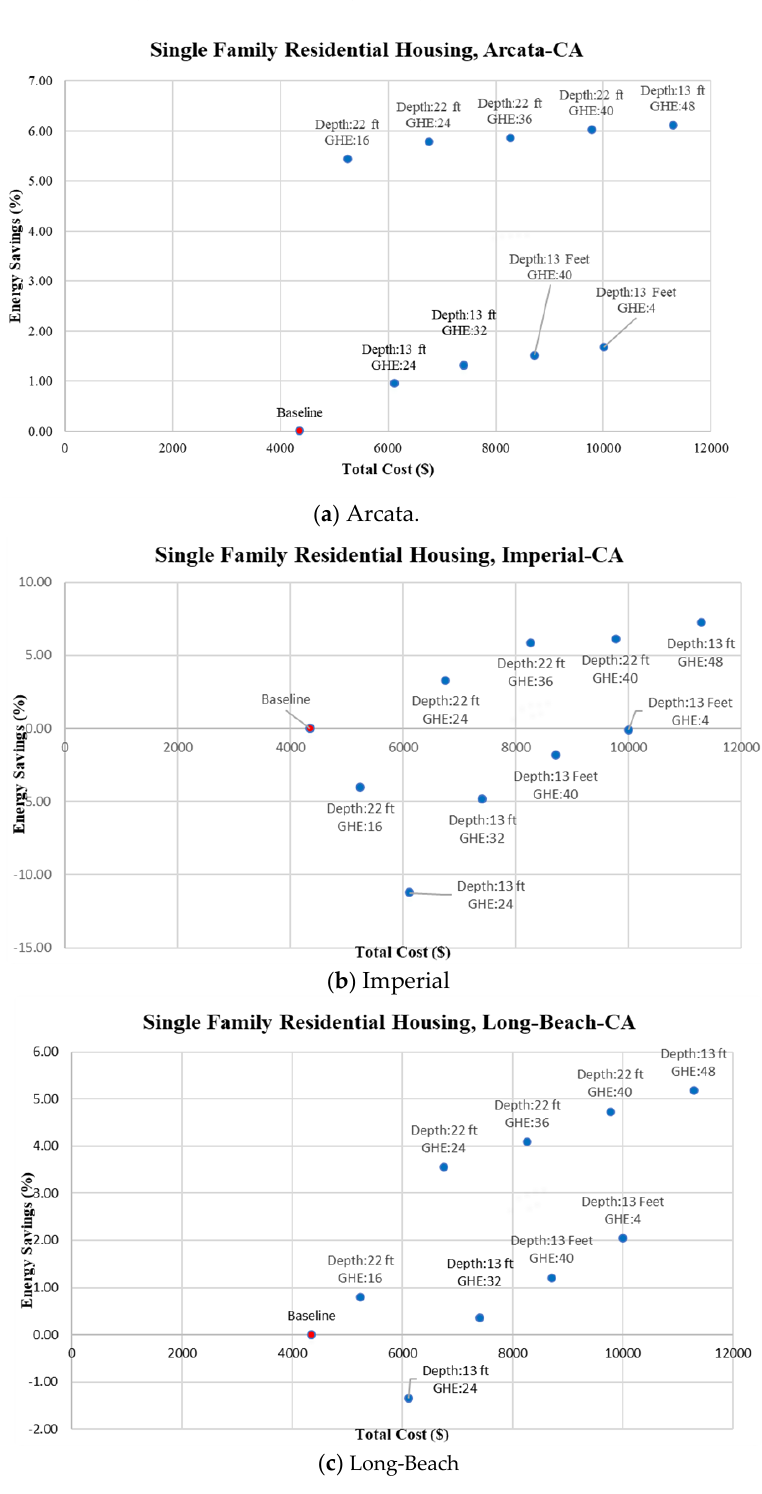
Figure 13. Energy savings vs. total cost for various configurations of S-GHSPs for three CA locations.